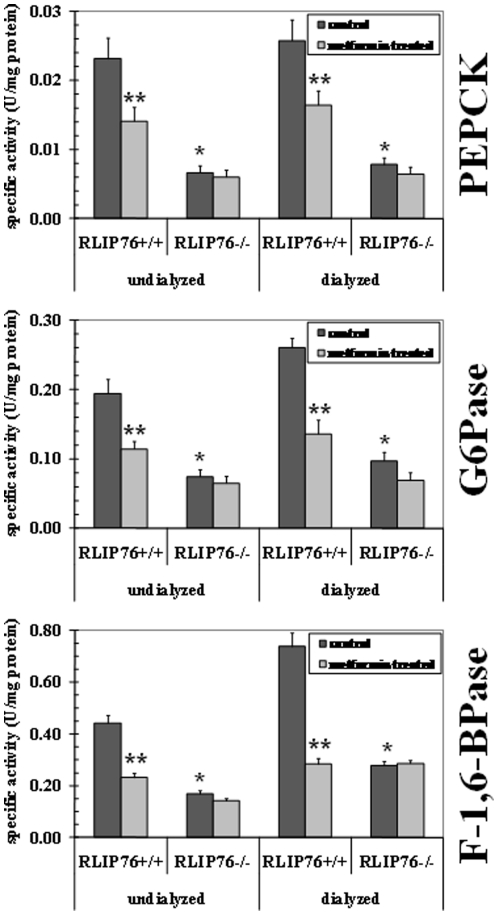
The activity of gluconeogenesis enzymes.The activity of PEPCK, F-1, 6-BPase, and G6Pase was tested in un-dialyzed and dialyzed liver homogenates of control and metformin treated RLIP76+/+ and RLIP76−/− mice (n = 3) as protocols standardized by us [1]. *p<0.001, when compared to RLIP76+/+, and **p<0.005, when compared with metformin treatment in RLIP76+/+. The enzyme PEPCK, catalyze the conversion of phosphoenolpyruvate to fructose 1,6-biphosphate in a series of steps involving oxidation of NADH to NAD. In this assay, the loss of NADH was determined spectrophotometrically by measuring absorbance at 340 nm, based on the method of Opie and Newsholme [28]. To detect F-1, 6-BPase activity, a spectrophotometric coupled enzyme assay was used by a method of Taketa and Pogell [29]. F-1, 6-BPase activity was coupled with phosphoglucose isomerase and NADP dependent glucose 6-phosphate dehydrogenase, and NADPH formation was measured at 340 nm. G6Pase activity was determined spectrophotometrically using the method of Gierow and Jergil [30]. The method is based on a coupled enzyme reaction in which glucose formed is reacted with glucose oxidase and peroxidase and the quinoneimine formed is a colored product and its formation can be followed spectrophotometrically at 510 nm.